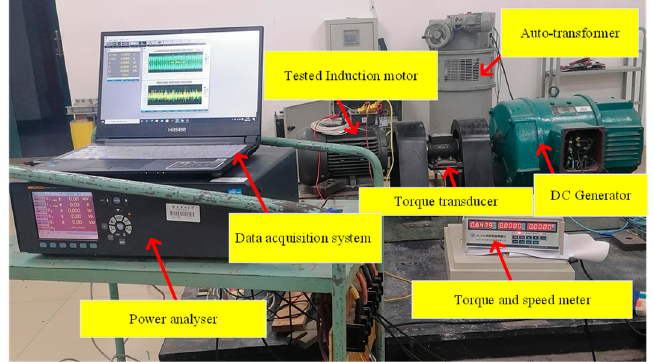
Figure 3. Test rig of 5.5 kW motor. Table 2. Ratio of X 1 / X 2 according to the design class